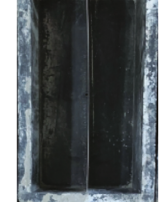
Figure 1: Mold making.